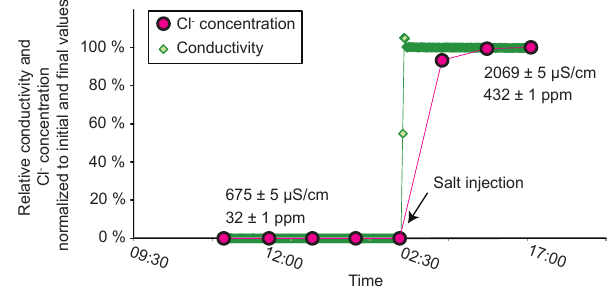
Figure 3. Cross-contamination assessment and response time of the RL system after a spike injection of 200g of NaCl. A closed sys- tem is established on the primary circuit of the RL by connecting the inlet and outlet through a 300L tank of river water prior to the injection. The conductivity measurement frequency is 1 per minute, whereas the time between two measurements of chloride concen- tration is 40min. Error bars for conductivity and Cl − concentration measurements are within symbols’ size. Results are normalized to the difference between the minimum value, before the tracer injec- tion (0%), and the maximum value, at the end of the experiment